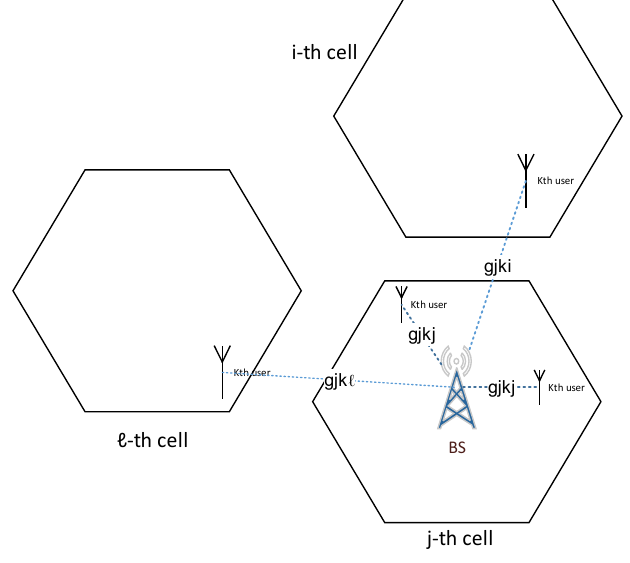
Figure 4. Interference due to the pilot contamination at uplink channel.